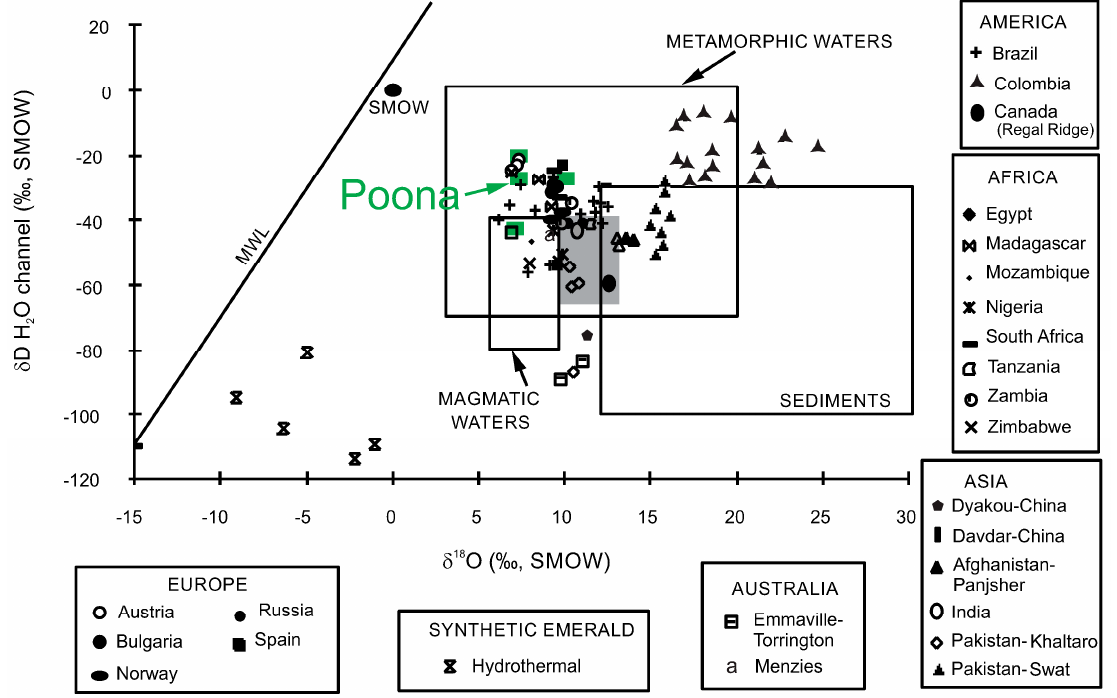
Figure 10. Channel δ D H 2 O versus δ 18 O for the Poona emerald (green rectangles; Table 4) superimposed on data from a number of world localities compiled from [6,28]. The isotopic compositional fields are from [42], including the extended (Cornubian) magmatic water box (grey). MWL = Meteoric Water Line, SMOW = standard mean ocean water.